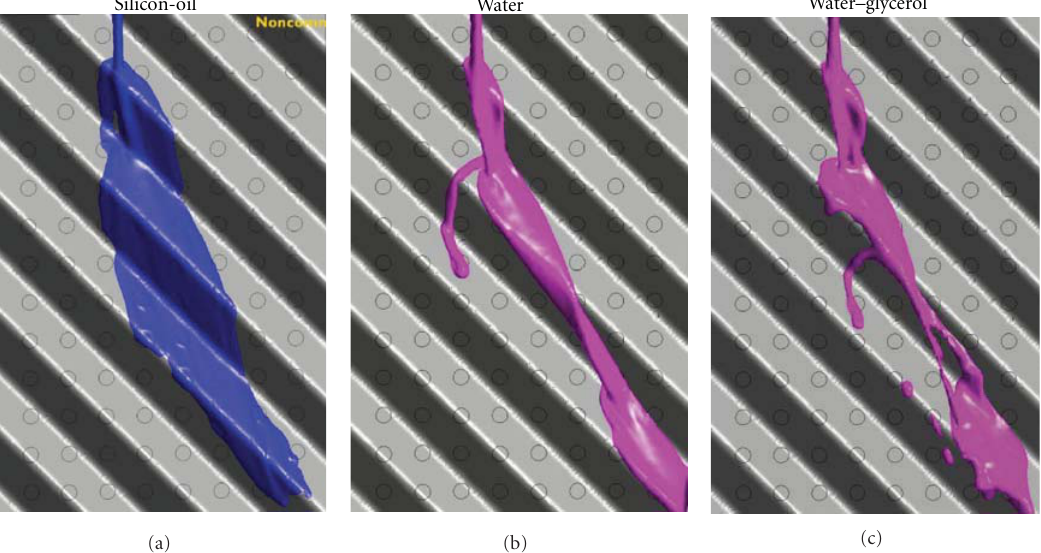
Figure 7: Snapshot from simulation for wetting behaviour of silicon-oil (DC5) and water and water-glycerol on corrugated sheet of packing without holes.